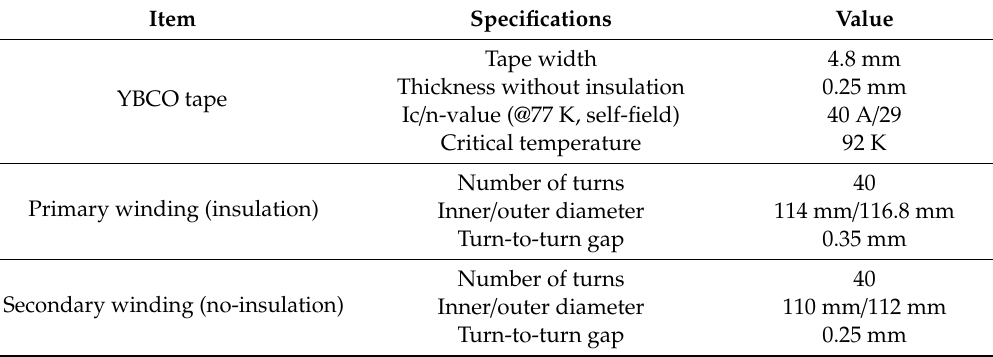
Table 1. Specifications of SFCL model.